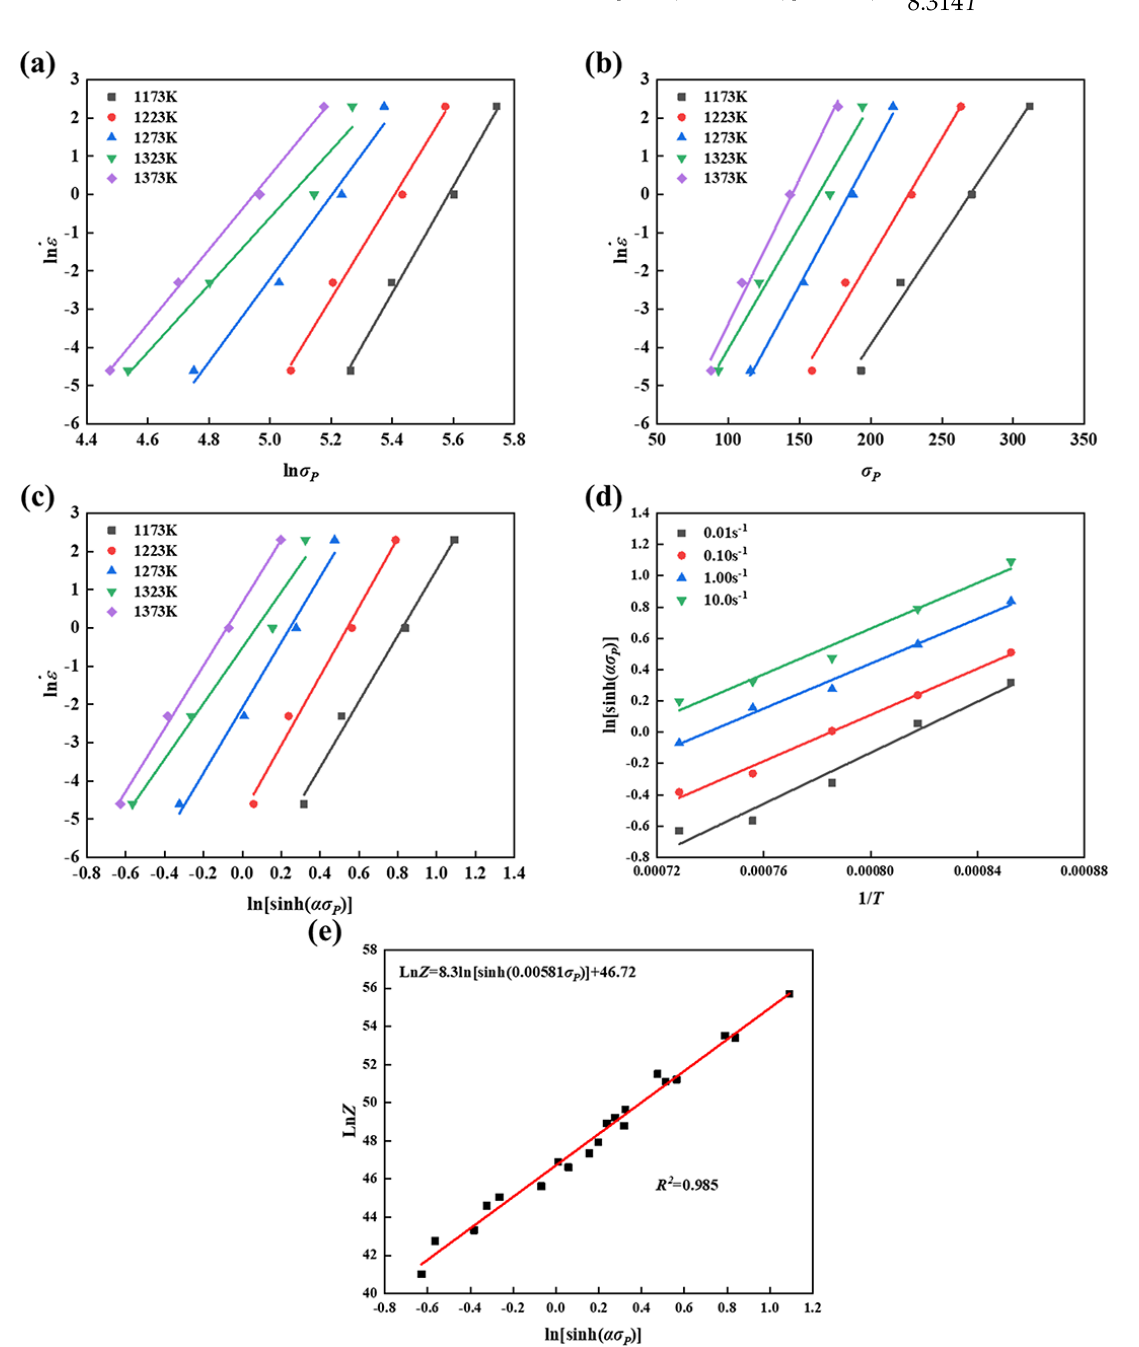
Figure 3. Plots used for calculation of the material-dependent constants. ( a ) ln ε ̇ -ln σ P , ( b ) ln ε ̇ - σ P , ( c ) ln ε ̇ -ln [ sinh ( ασ P )] , ( d ) ln [ sinh ( ασ P )]-1/ T , ( e ) ln Z -ln[ sinh ( ασ P ) ] (the units of peak stress and strain rate are MPa and s −1 , respectively).